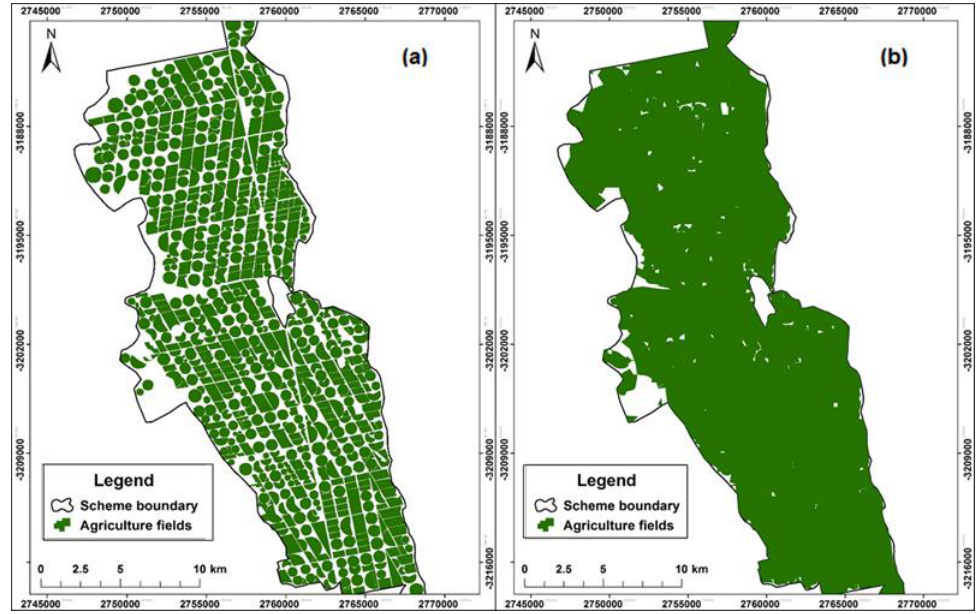
Figure 2. Comparison in the accuracy of UAV image derived map ( a ) and satellite image derived map ( b ). ( a ) shows the actual shape of agricultural fields and yet ( b ) resembles the whole scheme area as cultivated, overestimating the cultivated area. ( a ) was developed by the authors using a drone and ( b ) was derived from the irrigated area map developed by the International Water Management Institute (IWMI) (www.iwmi.cgiar.org/2018/06/irrigated-area-mapping-asia-and-africa/).